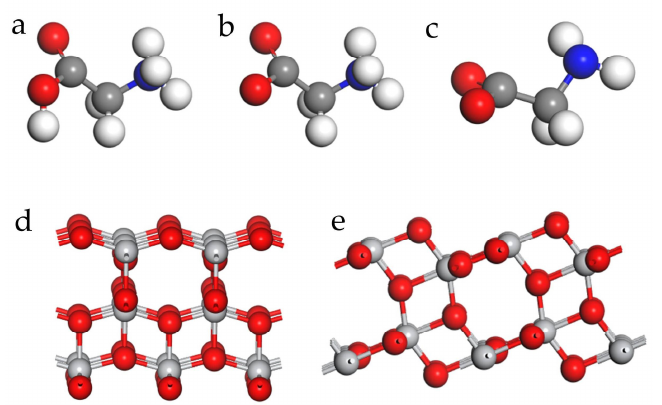
Figure 7. Three dissociation states of glycine and two kinds of anatase TiO 2 : ( a ) positive dissociated Gly ions; ( b ) ZW zwitterions; ( c ) negative dissociated glycine ions; ( d ) anatase (TiO 2 ) with exposed (001) facets; ( e ) anatase (TiO 2 ) with exposed (101) facets.